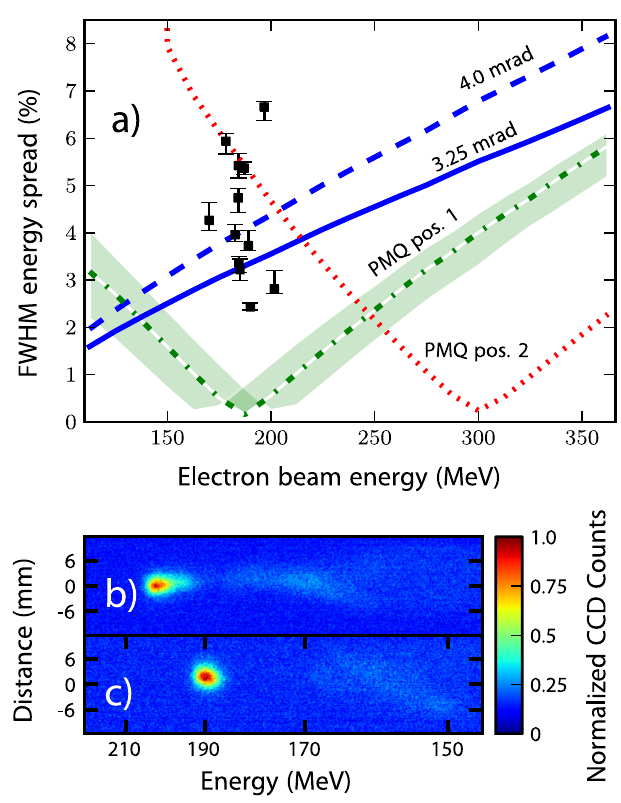
FIG. 4. Energy resolution improvement: (a) A monoenergetic electron beam entering a dipole magnet spectrometer will have its measured energy spread artificially enlarged by its diver- gence. This is shown for two cases, monoenergetic electron beams with an initial FWHM divergence of 3.25 mrad (solid blue line) and 4.0 mrad (dashed blue line). These errors can be significantly reduced for any energy that can be focused on the observation plane at S2 by the magnetic lenses. The green (dash- dotted) and red (dotted) curves show the calculated measurement accuracy for two different lens positions. The green shaded area shows the effect of misaligning the second lens by (cid:6) 5 mm . Black squares represent measured energy spreads with the lens system focusing 190 MeV (corresponding to the green dash- dotted curve). Parts (b) and (c) show false color images of electron spectra observed at S2 for this lens setting with FWHM energy spreads of 2.8% (b), and 2.4%